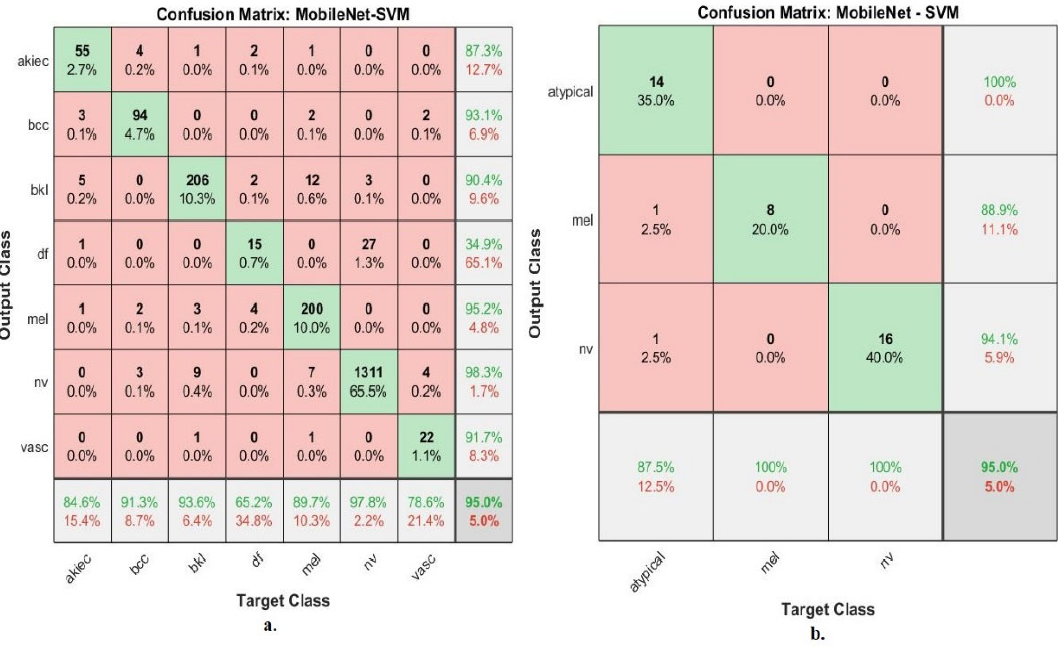
Figure 11. Confusion matrix for the classification of two skin lesion datasets by SVM with MobileNet features through datasets of ( a ) HAM10000 and ( b ) PH2.